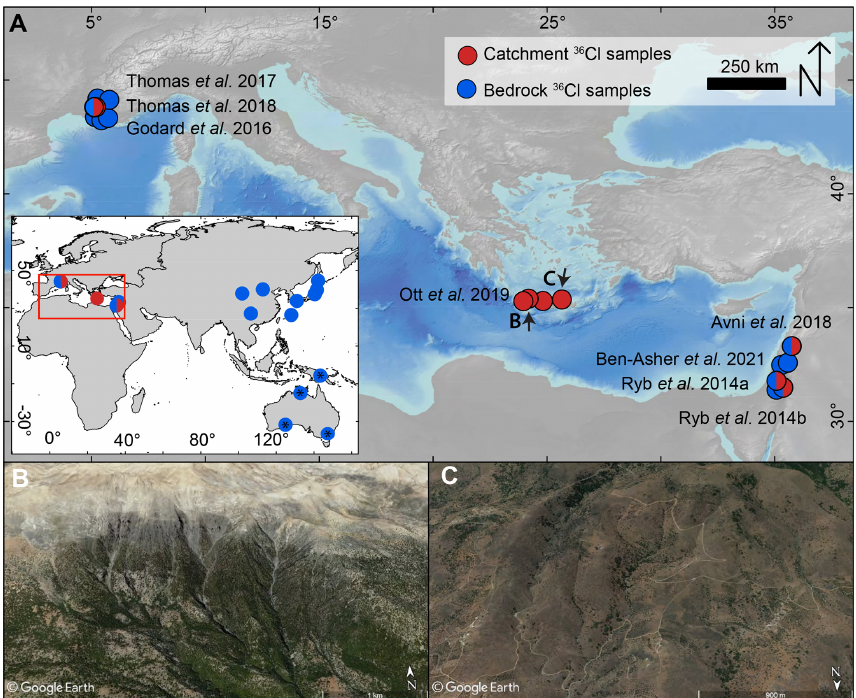
Figure 1. (a) Location of 36 Cl denudation rate measurements compiled for this study in the Mediterranean and globally (inset). ∗ Samples not included due to lack of location and compositional data. (b) Typical steep carbonate catchment in the Lefka Ori range in Crete, Greece, with partial forest cover and small landslide scars. (c) Typical low relief catchment in